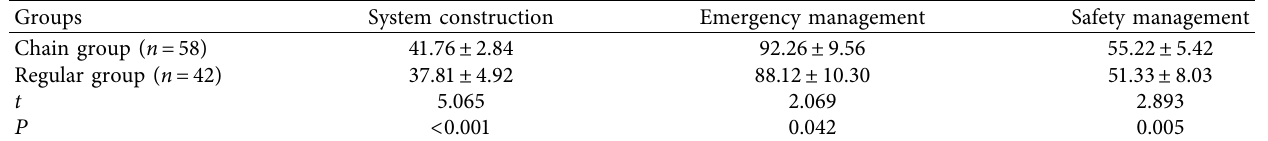
Table 4: Comparison of nursing quality between two groups ( x ± s , points).